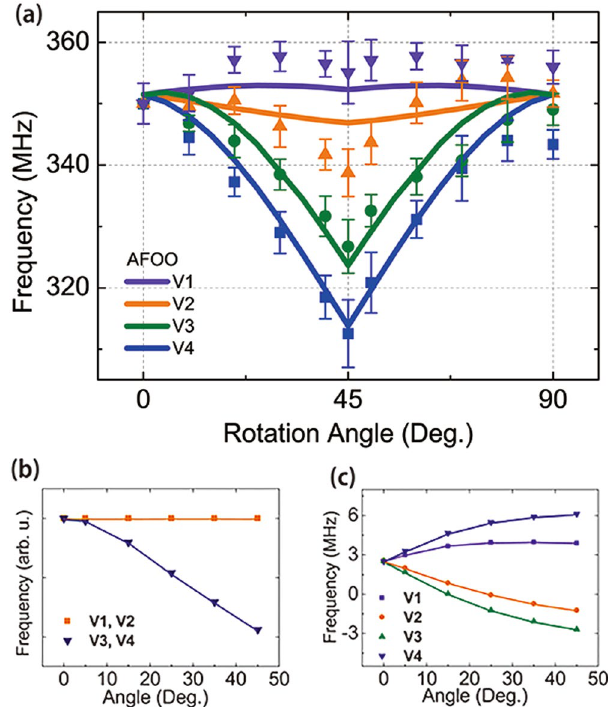
Figure 3. ( a ) V 3 + NMR frequency versus the field angle. Four different symbols and colors represent the four split peaks in the V NMR spectra. The Solid lines represent the fit for the antiferro-orbital order. Frequency shifts expected for the yz - zx antiferro-orbital ordering in V ions due to ( b ) the anisotropic hyperfine field and ( c ) the dipolar field from neighboring spins. The lines in ( b ) and ( c ) are guides for the